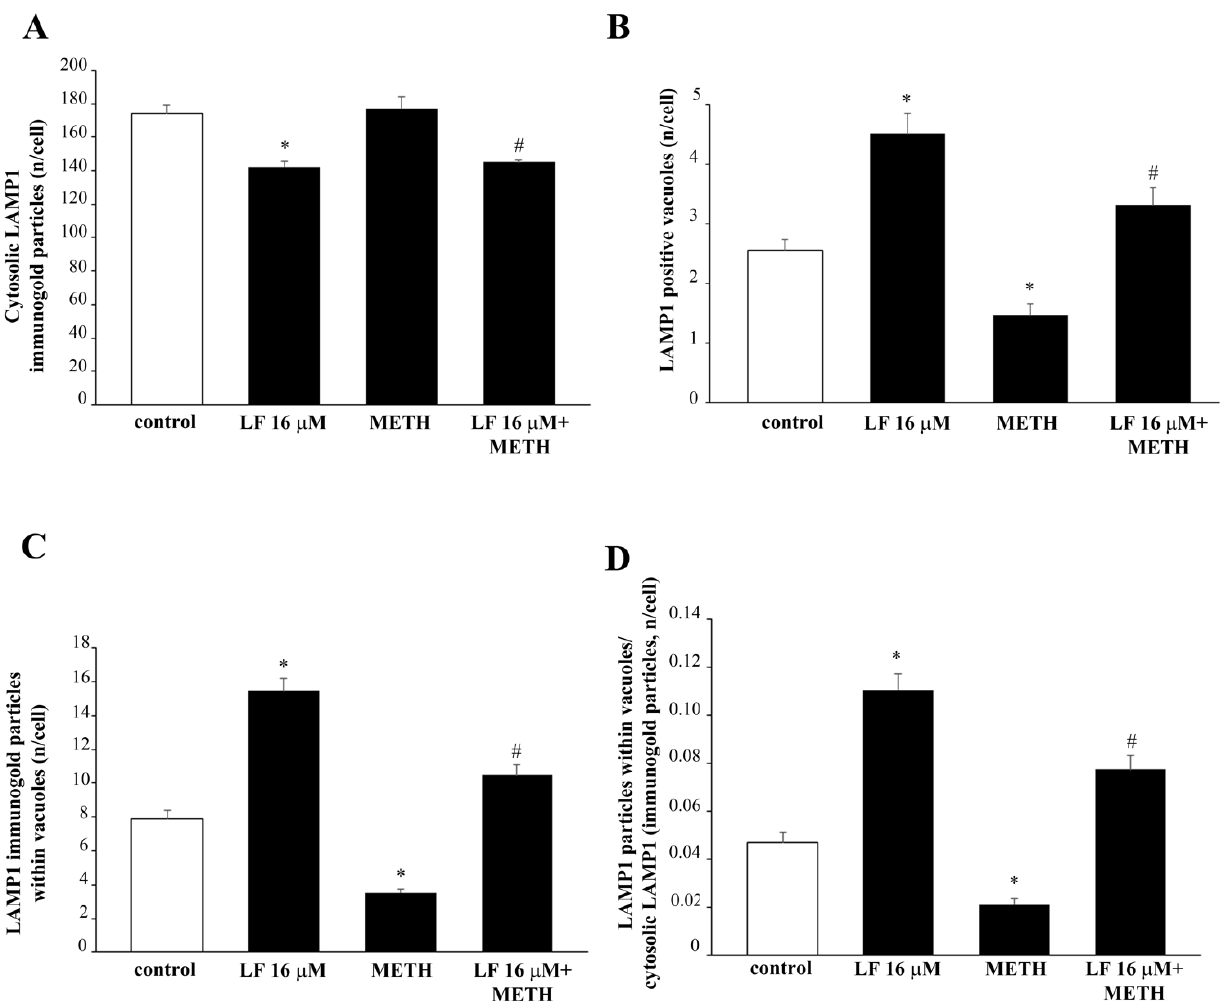
Figure 16. Lactoferrin increases LAMP1 compartmentalization within vacuoles. Graphs ( A – D ) report the ultrastructural morphometry for LAMP1. ( A ) = * p <0.05 compared with control; # p < 0.05 compared with control and METH; ( B ) = * p < 0.05 compared with control; # p < 0.05 compared with METH ( C ) = * p < 0.05 compared with control; # p < 0.05 compared with METH; ( D ) = p < 0.05 compared with control; # p < 0.05 compared with METH.